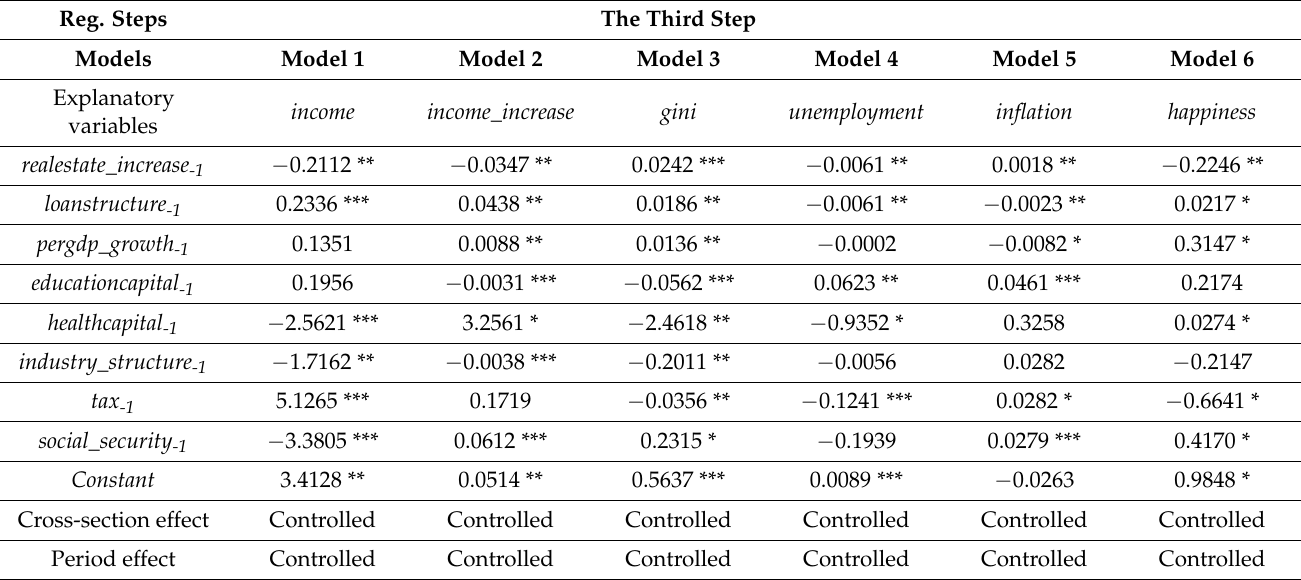
Table 6. Intermediary effect test results of real estate investment impact national happiness through the financial institutions’ loan structure (third